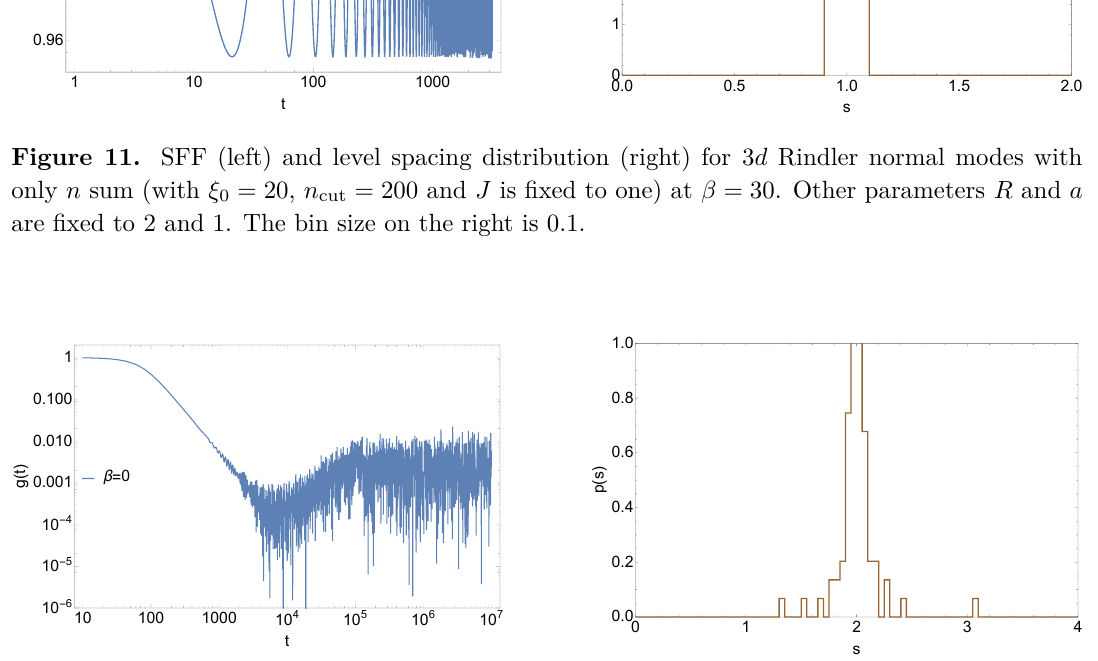
Figure 12. SFF (left) and its corresponding level spacing plot (right) for 3 d Rindler normal modes with ξ = 20 , J = 300 , n is fixed to one and β = 0 . Other parameters R and a are fixed to 2 and 0 cut 1 . The bin size on the right is 0.05.